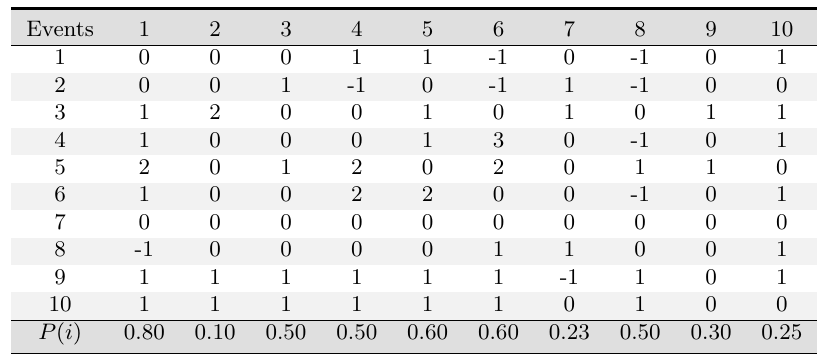
Table 2: The 10 × 10 causal cross-impact matrix, where the column events (driving events) affect the row events (driven events).